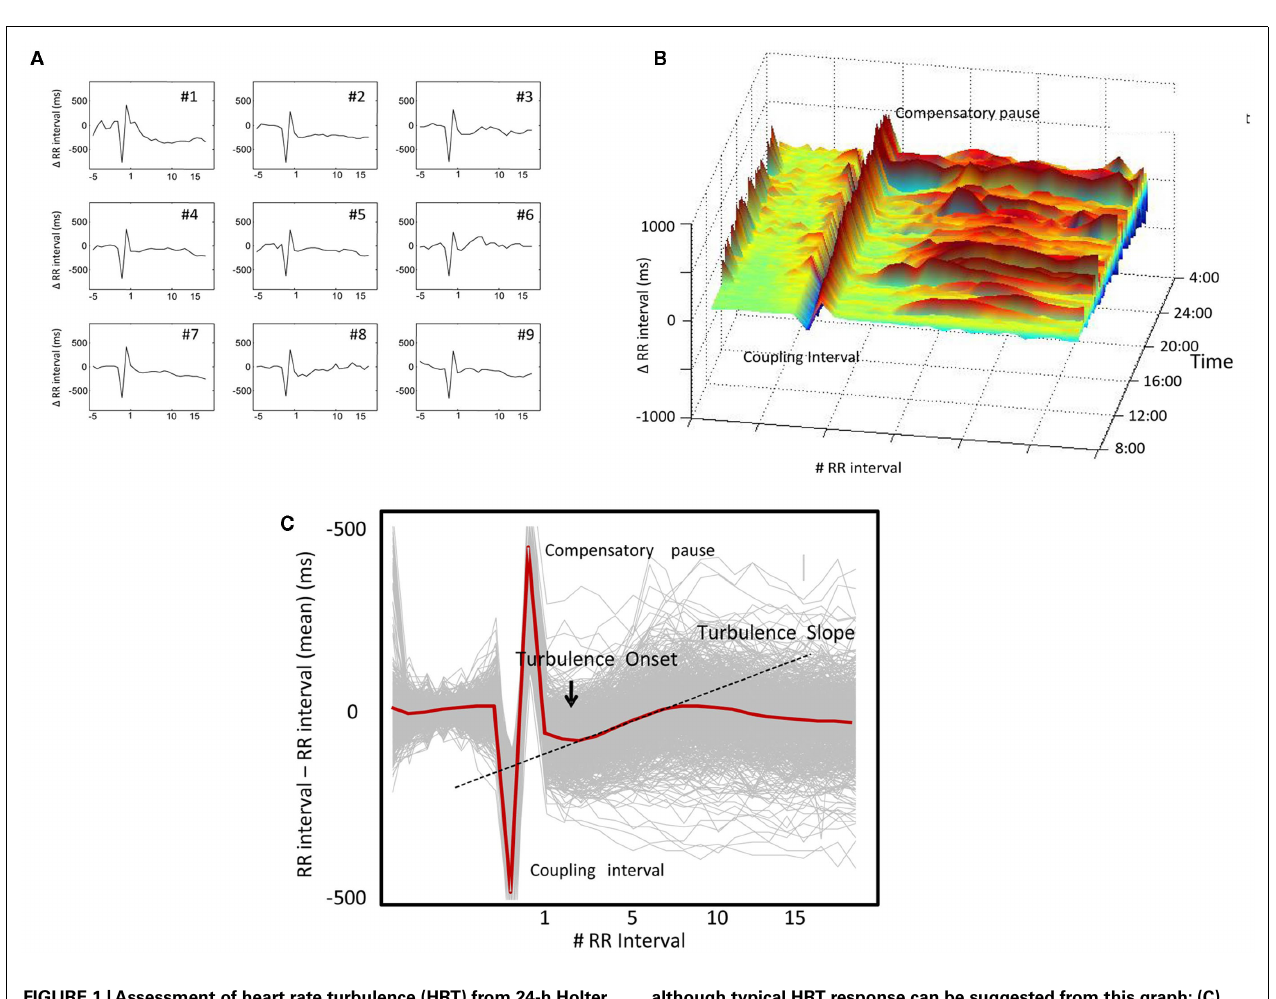
FIGURE 1 |Assessment of heart rate turbulence (HRT) from 24-h Holter recordings: (A) high variability in single “local tachograms” surrounding randomly selected ventricular premature complexes (VPCs); (B) high circadian variability in single local tachograms observed over 24h;